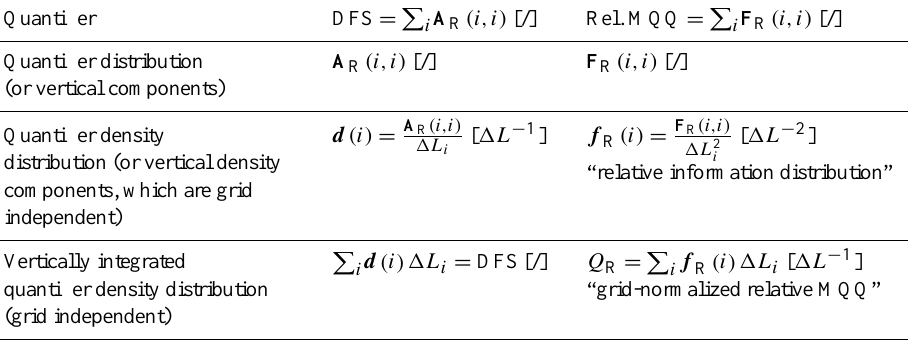
Table 3. Degrees of freedom of the signal (DFS) and relative measurement quality quantifier (MQQ), together with related quantities, with A R the fractional AKM, F R the fractional FIM, and (cid:49)L the layer thickness in km or log pressure. Units are provided between